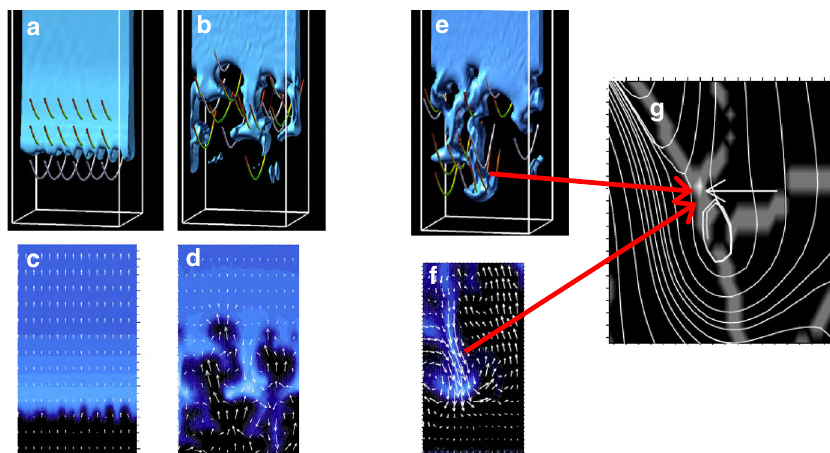
Fig. 18 Vertical flows in prominence sheets associated with the Magnetic Rayleigh–Taylor (MRT) insta- bility. a A KS-type prominence model is perturbed by c a low-density/high-temperature region at its base, resulting in b / d RT unstable upward flows (from Hillier et al. 2012a). e – g Reconnections in this evolving plasma result in downward acceleration of fast-moving, dense blobs (from Hillier et al. 2012b). Images reproduced with permission, copyright by